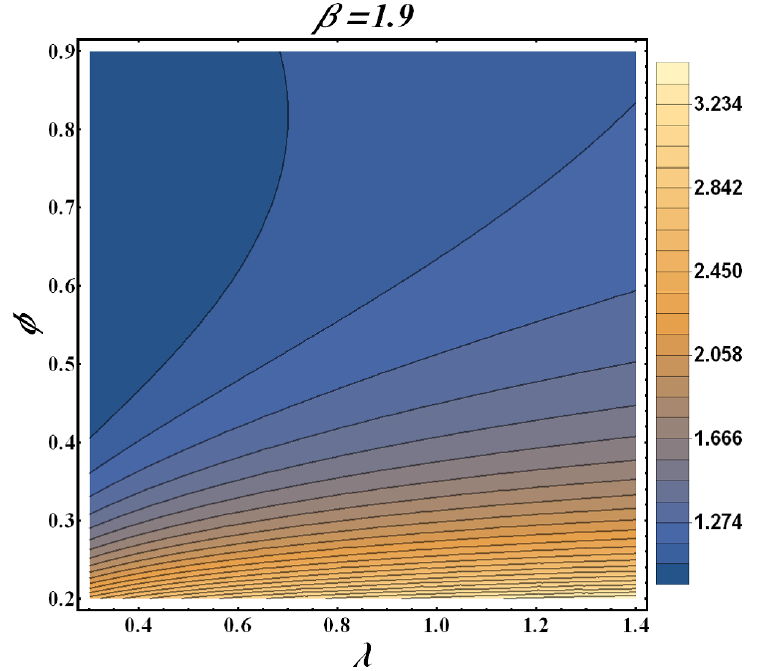
(cid:0) ˘ Θ (cid:1) Figure 6. Plot of kurtosis of HLUG-TI for certain parameter values. Fig. 6. Plot of kurtosis of HLUG-TI for certain parameter values. Fig. 6. Plot of kurtosis of HLUG-TI for certain parameter values.